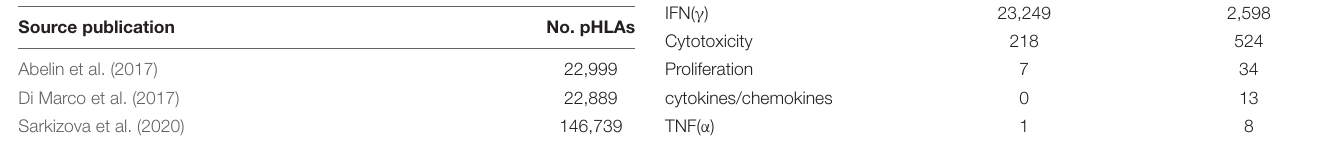
FIGURE 1 | Venn diagram showing the number of unique and common peptides among datasets. TABLE 1 | The total number of pHLAs included in our model from each dataset.